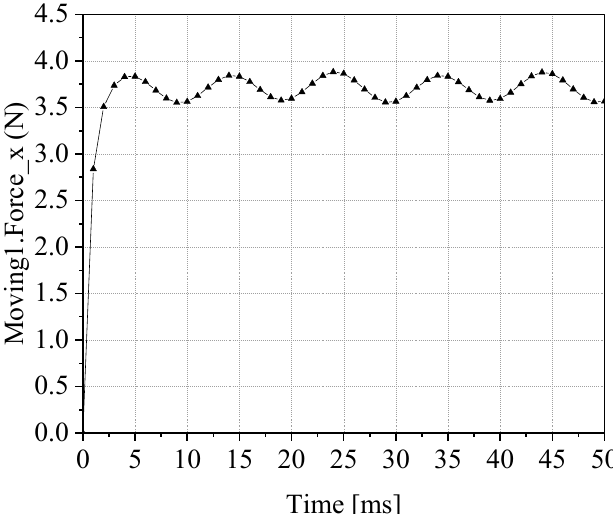
Figure 7. The thrust waveform generated after finite element optimization. Table 3. Before and after optimization. Original Parameter Optimized